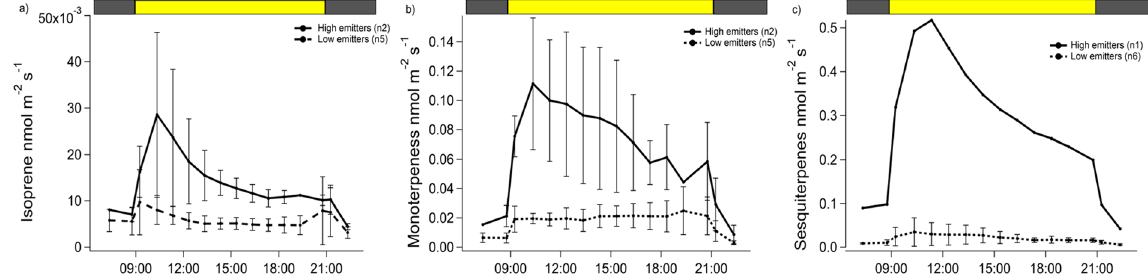
Figure 2. Diurnal cycles of the emission rates of isoprene ( a ), monoterpenes ( b ) and sesquiterpenes ( c ) by seven individuals of H . halimifolium . The thick line represents the high emitter group and the dashed line the low emitter group. Error bars indicate one standard deviation. Note that for sesquiterpenes only one plant represents the high emitter group. The top bar indicates the light (yellow) and dark (grey) periods.